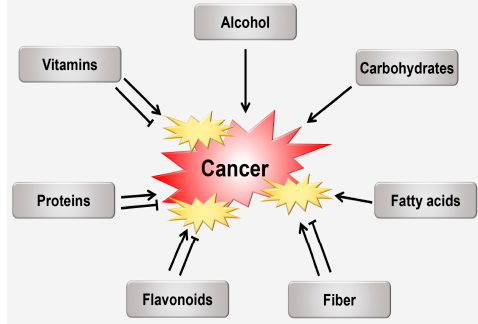
Figure 4. Some vital dietary factors have been associated with various aspects of cancer progression. Arrows represent activation of cancer and T bar represent inhibition.